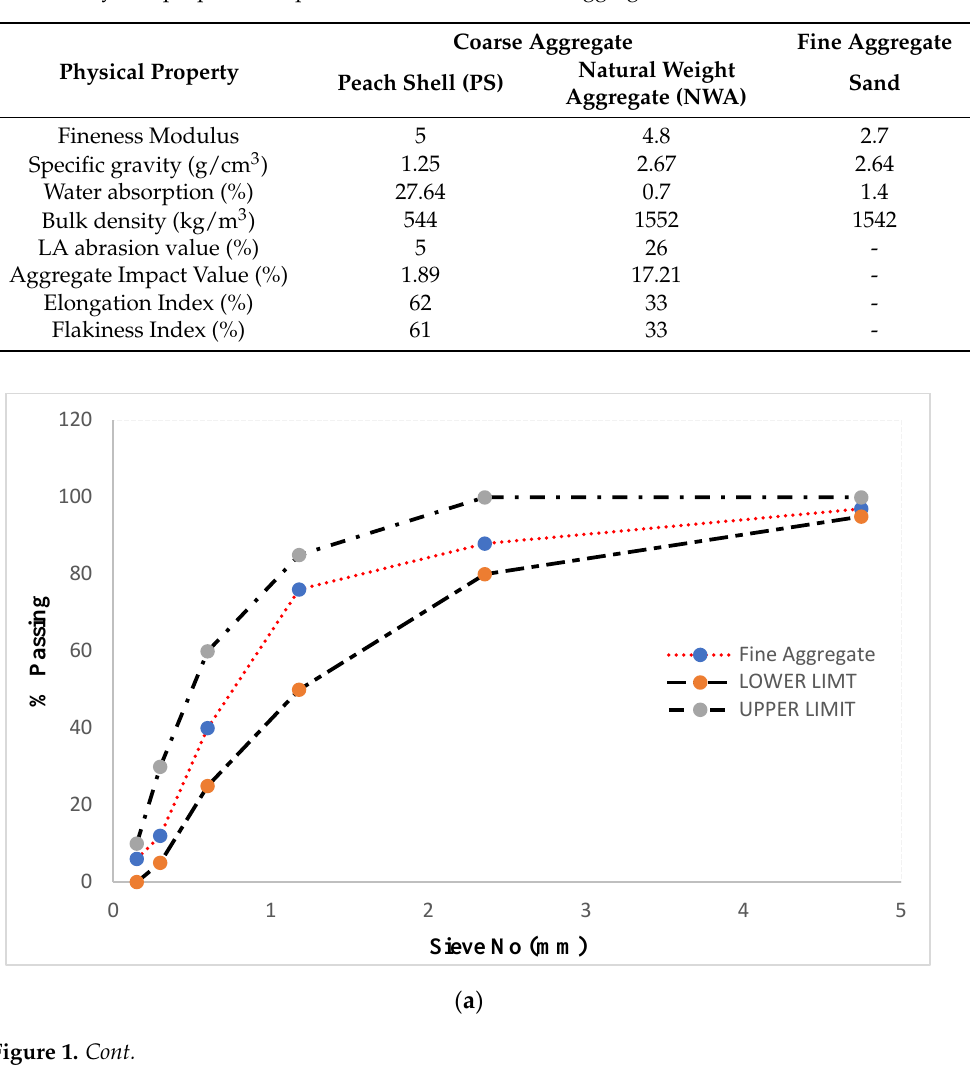
( b ) Figure 1. ( a ) Gradation curve of fine aggregate, ( b ) gradation curve of peach shell and coarse ag- gregate.